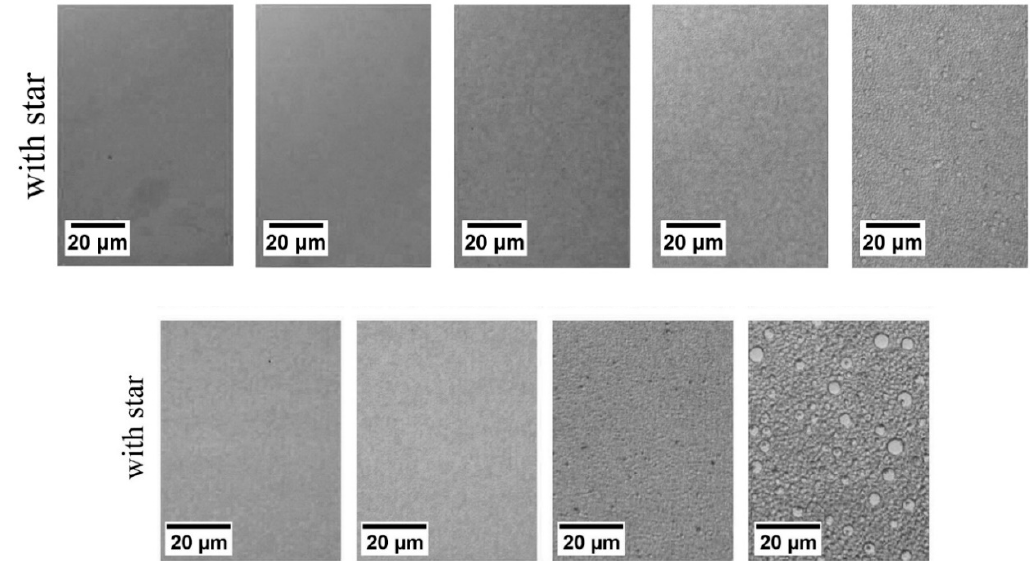
Figure 14. Compatibilized spun-cast films with constant 1 wt % CD core. The top row of films contain 0 wt %, 1 wt %, 5 wt %, 10 wt %, and 20 wt % PDMS (MW = 308,000) from left to right. The bottom row of films contain 1 wt %, 5 wt %, 10 wt %, and 20 wt % PDMS, and were thermally held above the T g of PS at 125 °C for 3 days under N2. Reproduced from [14] with permission, copyright Elsevier, 2010.